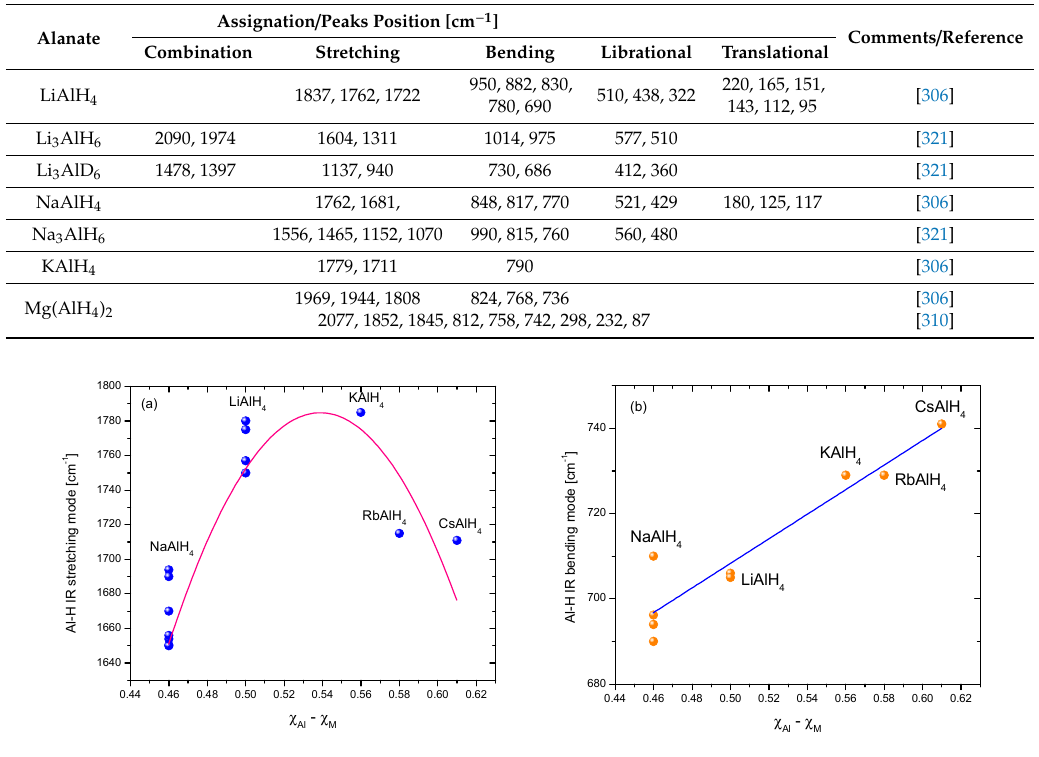
Figure 29. Most intense peak of infrared vibrations in the group 1 alanates, MAlH 4 . ( a ) Stretching, ( b ) Bending.